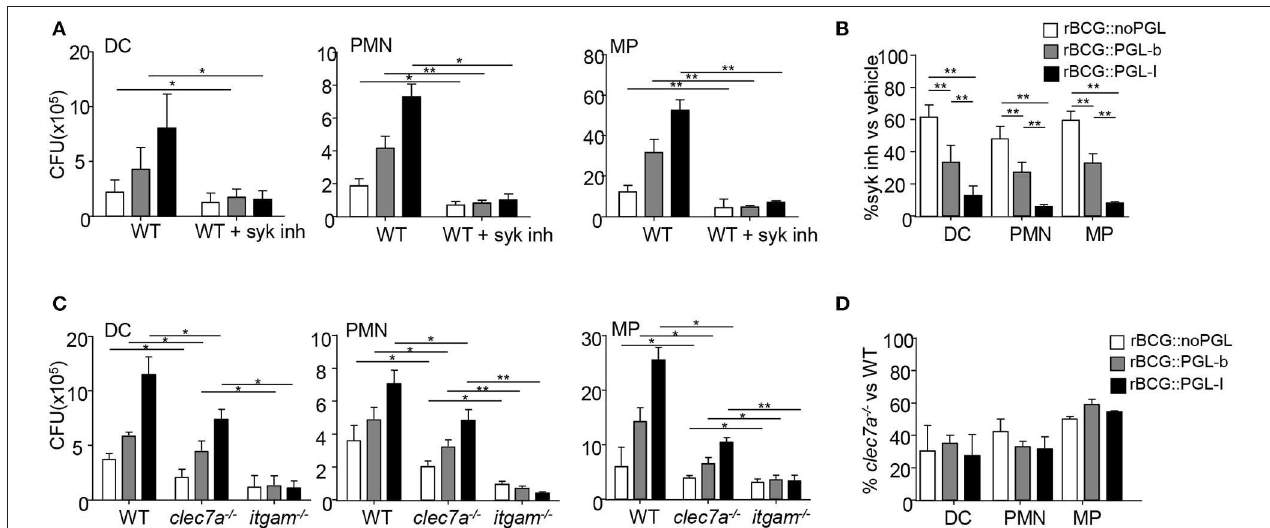
FIGURE 2 | The Syk pathway regulated by CR3 engagement controls infection by rBCG::PGL-I (A) Number of CFUs recovered as in Figure 1A from DCs, PMNs, or MPs that were treated with vehicle or 1 µ M of Syk inhibitor GS-9973, 1h before infection with the rBCG strains ( n = 6). (B) Ratio of CFUs recovered from cells treated with the Syk inhibitor vs. vehicle for the three strains and cell types. (C) Number of CFUs recovered as in Figure 1A from DCs, PMNs or MPs derived from bone marrow of WT or itgam − / − or clec7a − / − mice harboring the dectin-1 deficiency specifically in myeloid cells (22) ( n = 4). (D) Ratio of CFUs from clec7a − / − vs. WT cells for the three strains and cell types. Data are presented as mean ± SEM * P < 0.05; ** P <